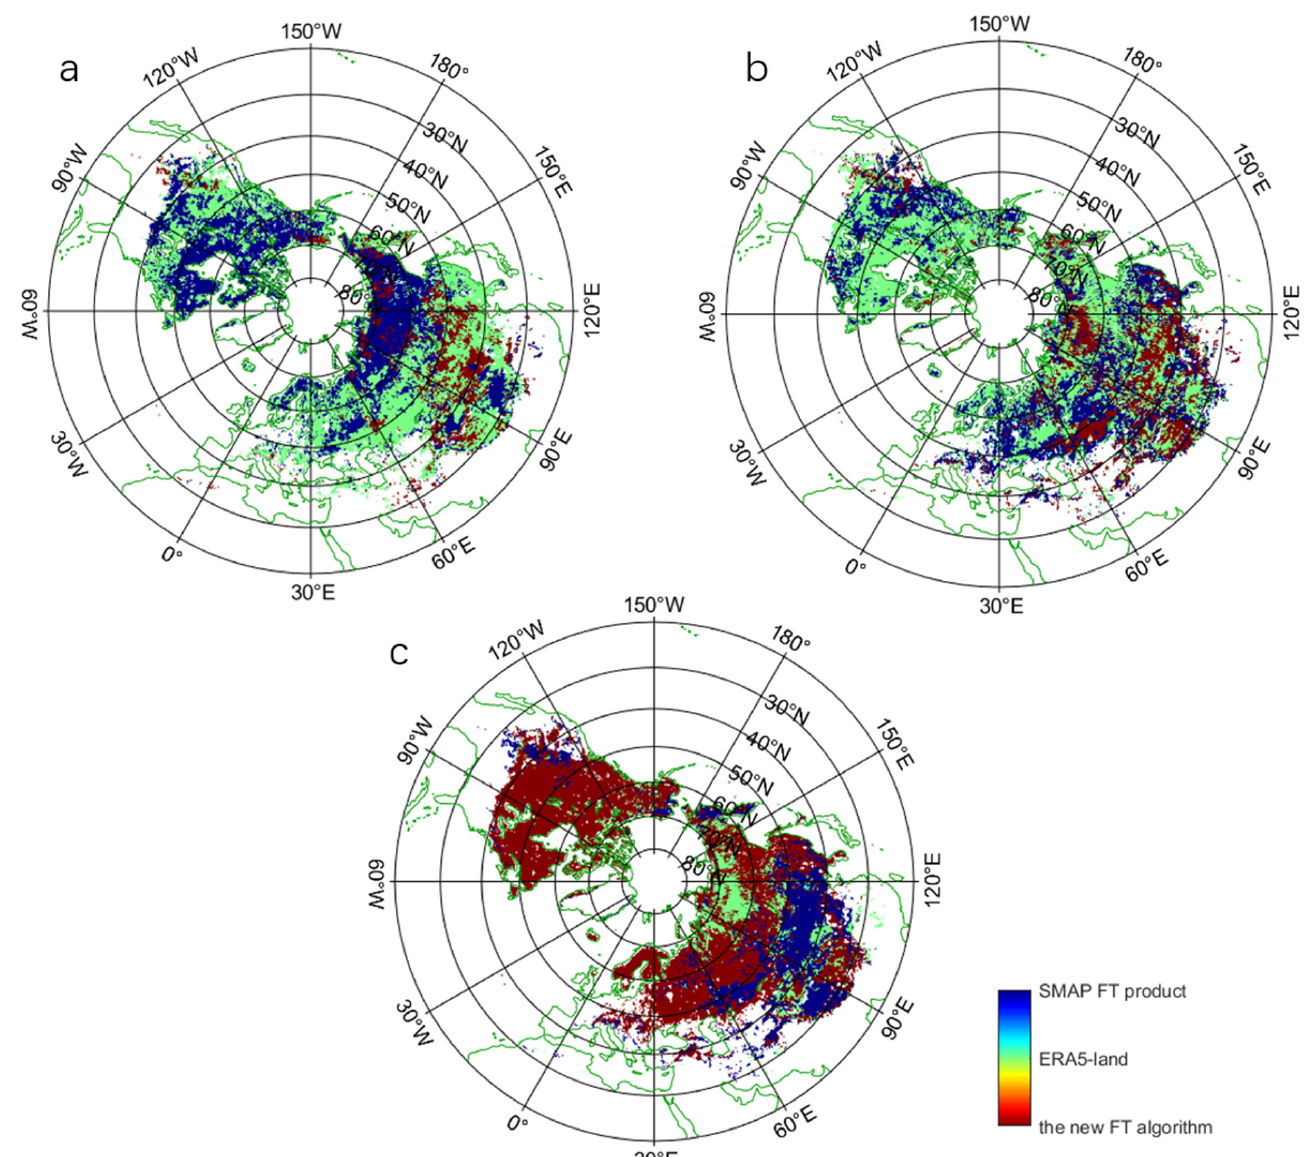
Figure 10. Map of the measurement system ranked first ( a ), second ( b ), and third ( c ) in the northern hemisphere ( ≥ 20N°) using CTC.